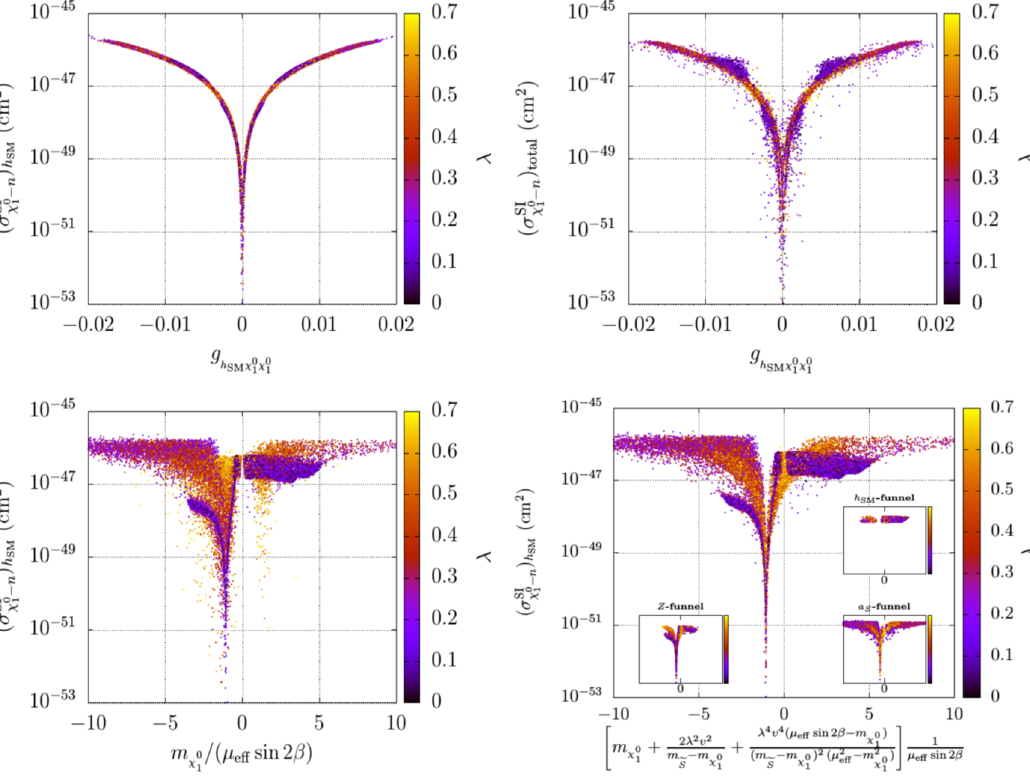
) (top, left) and ( σ SI ) (top, right) as functions of g h SM total χ 0 − n χ 0 − n 1 1 ) as a function of m / ( µ eff sin 2 β ) (bottom, left) and as a function of h SM χ 0 − n χ 0 1 1